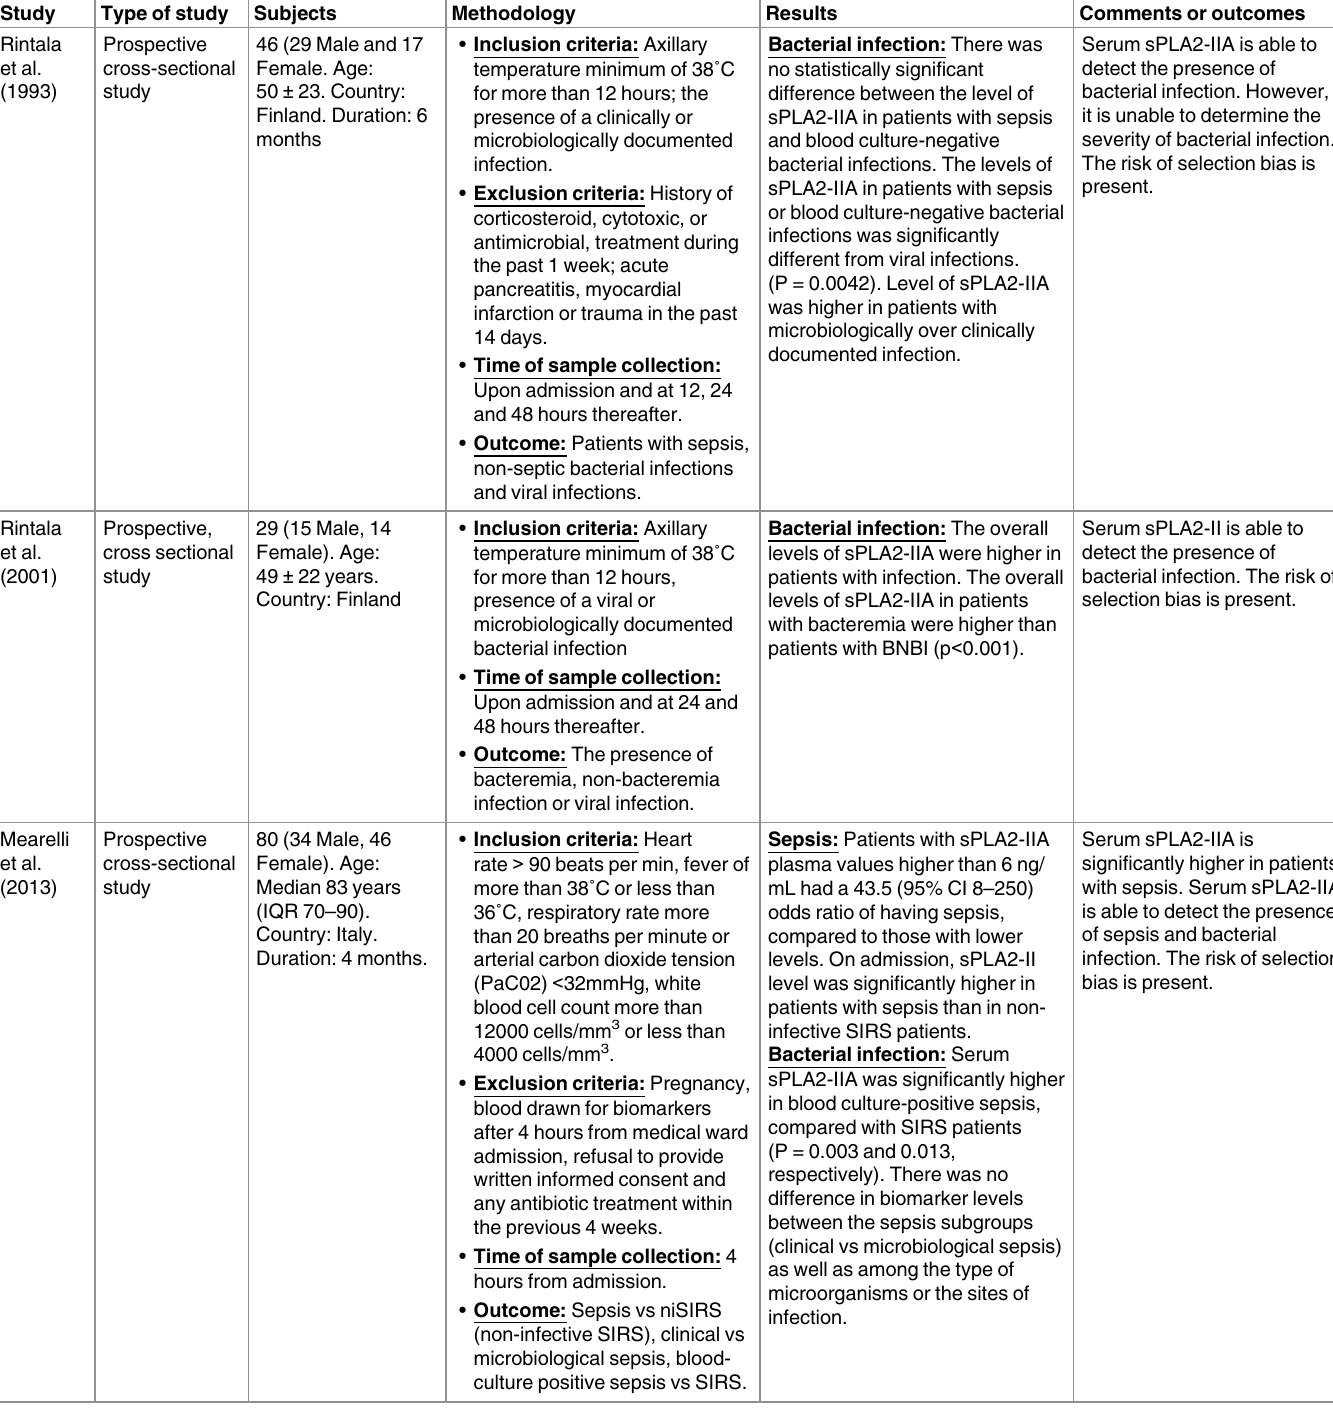
Table 1. The summaryof characteristics of the selected studies.